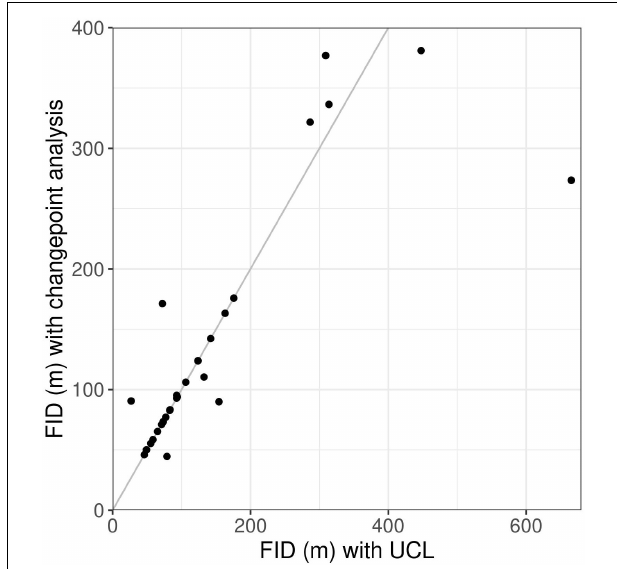
FIGURE 4 | Comparison of values for flight initiation distances (FID) of wolves when approached by humans, obtained using the two alternative methods changepoint analysis and upper control limit (UCL). Each dot represents one wolf-human interaction. Dots on the gray line indicate interactions in which the two methods gave identical FID